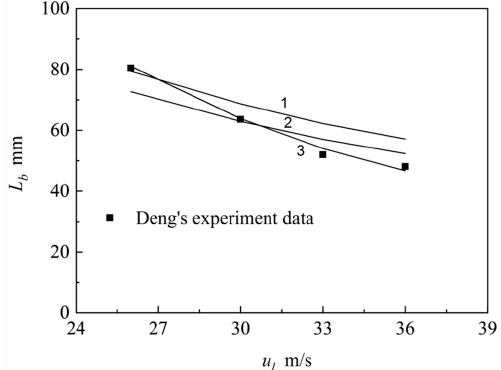
Figure 2. Comparison between Deng’s experiment data and the prediction curves in terms of breakup length L b as a function of jet velocity u l . Lines 1–3 represent ln( η b / η 0 ) = 12, 11, and variable ln( η b / η 0 ).